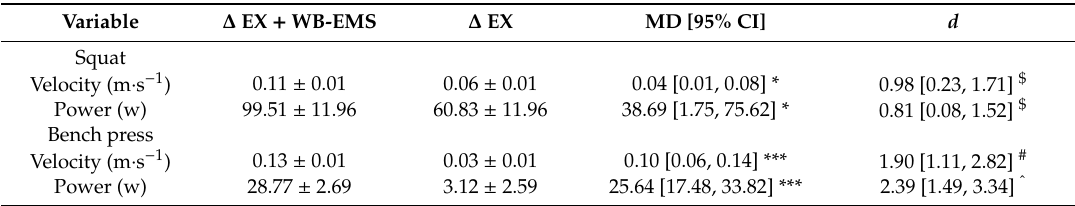
Values are presented as estimated mean ± SE. ∆ EX + WB-EMS: change score of exercise plus whole-body electrostimulation group; ∆ EX: change score of exercise only group; MD: mean di ff erence; CI: confidence interval; d